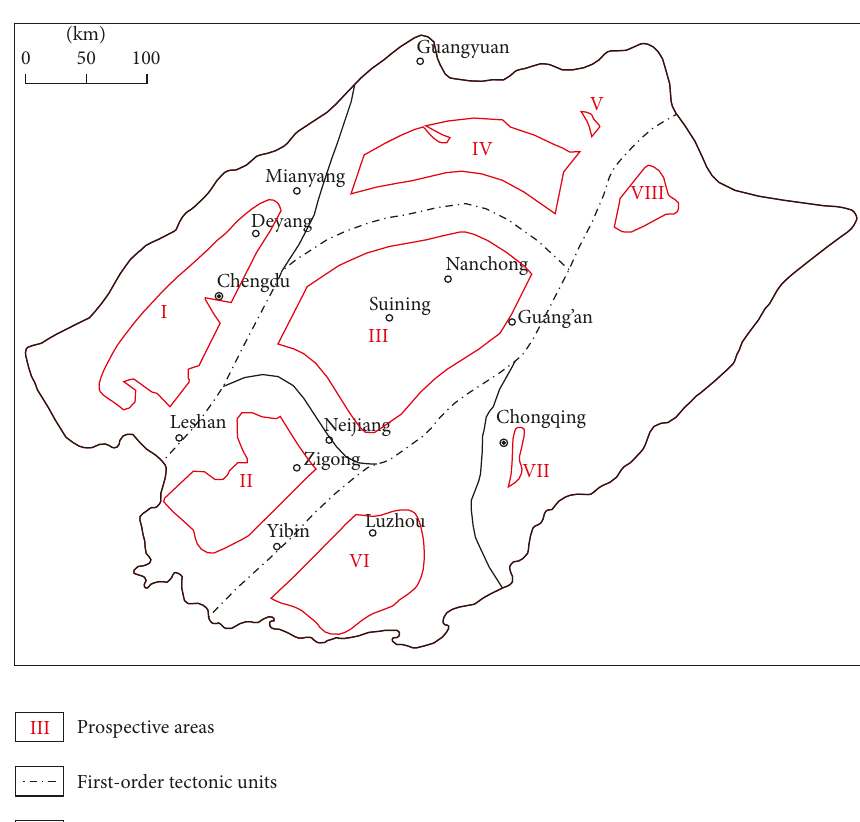
Figure 6: Candidate prospective areas in the Sichuan Basin. There are eight candidate prospective areas in the Sichuan Basin for deep saline aquifer CO 2 storage which cover more than 5 × 10 4 km 2 and mainly locate in Central Sichuan Basin (districts II–V). Only district I is in Northwestern Sichuan. The candidate prospective areas (districts VI–VIII) in Eastern Sichuan are relatively small due to the effects of formation depth, geological safety, and hydrogeological conditions.